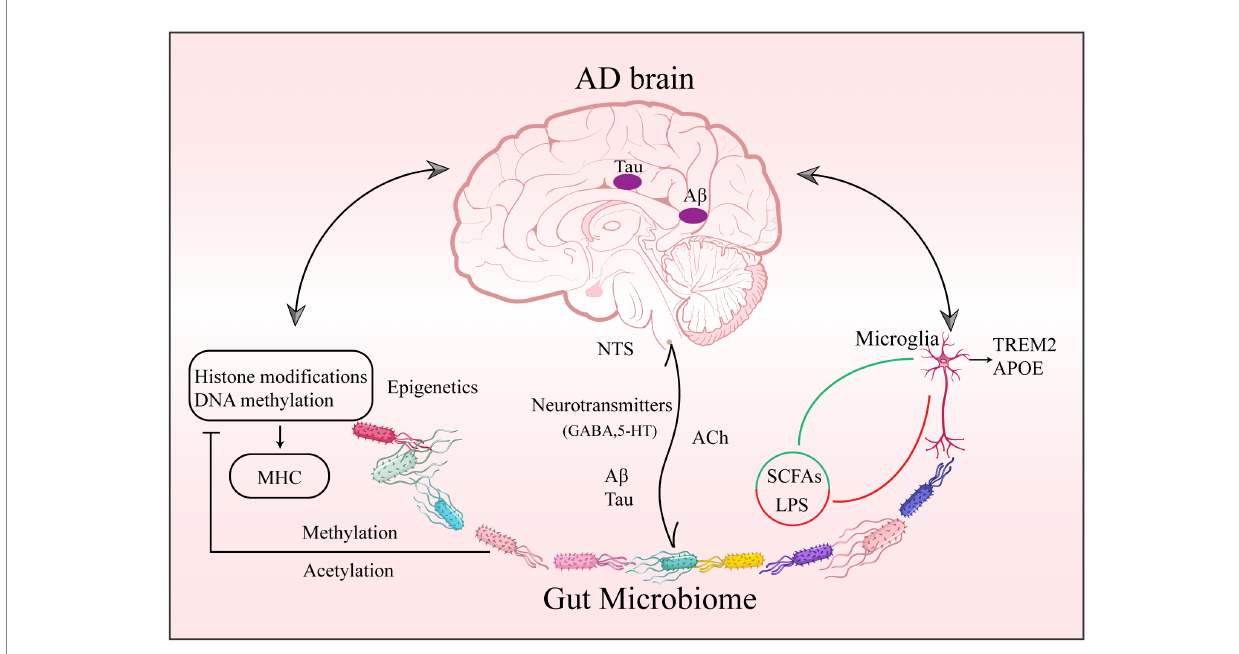
FIGURE 1 Gut Microbiome epigenetic, peripheral, and central pathology of AD. Changes in gut microbial composition, abundance, and metabolite diversity are involved in AD through epigenetic regulation of CNS function. (1) through acetylases, methylases, and deacetylases, affecting acetylation and methylation of DNA and histones; and (2) through microglia upregulation of APOE and downregulation of TREM2 associated with AD pathogenesis. Abbreviations: AD: Alzheimer’s disease; CNS: central nervous system; DNA: deoxyribonucleic acid; APOE: apolipoprotein E; TREM2: trigger receptor genes expressed on myeloid